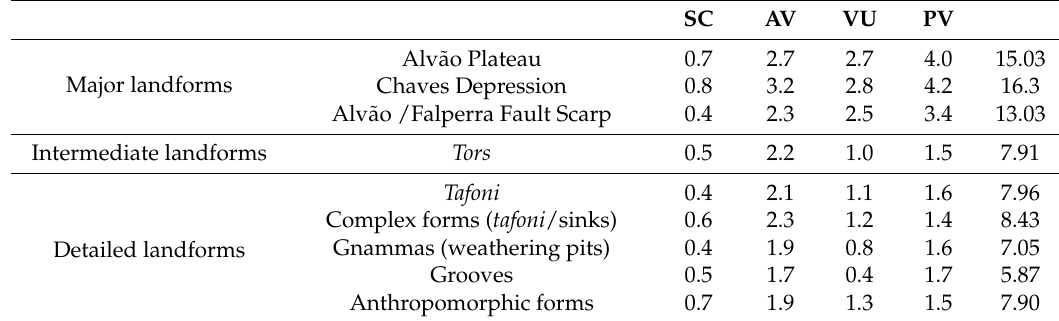
Figure 7. Preservation value (PV) for the different geomorphosites considering the parameters of damage (impacts to date) (Dit) and vulnerability to anthropogenic impacts (VAI). Table 4. Geomorphological interest value (GIV) obtained from the sum of scientific value (SV) and management value (MV).